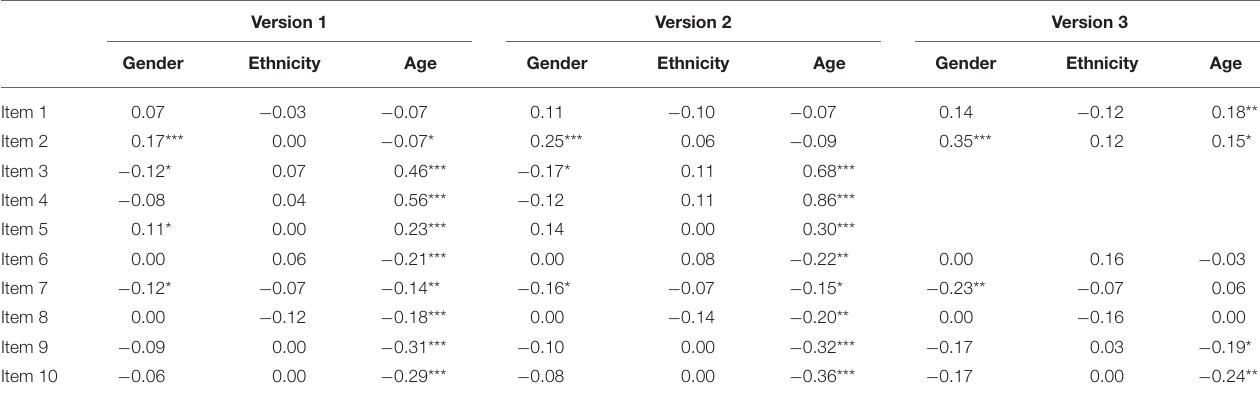
TABLE 4 | Differential item functioning by gender, ethnicity, and age